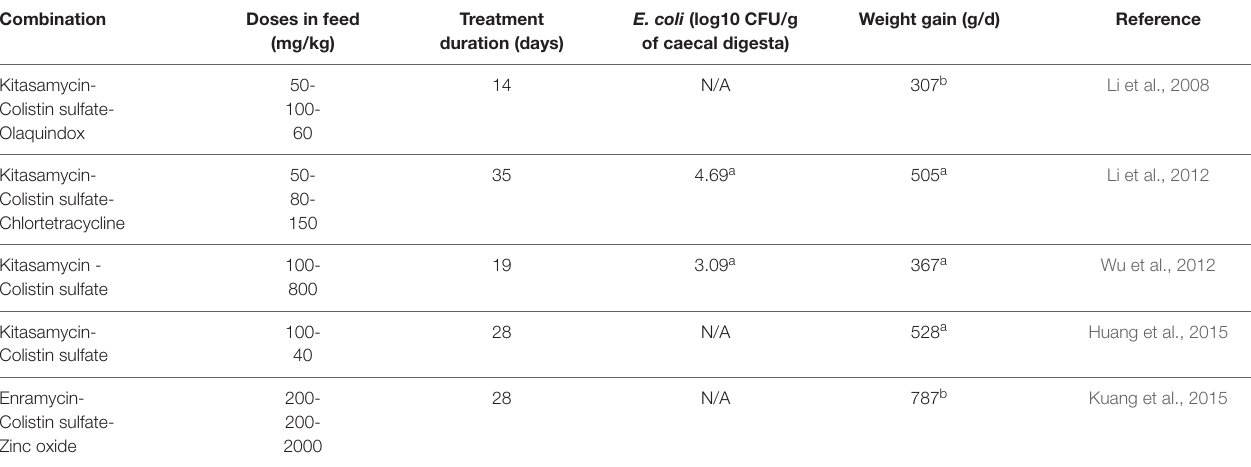
TABLE 4 | Colistin combination with other antimicrobial agents in scientific studies conducted in pigs. Combination Doses in feed Treatment (mg/kg) duration